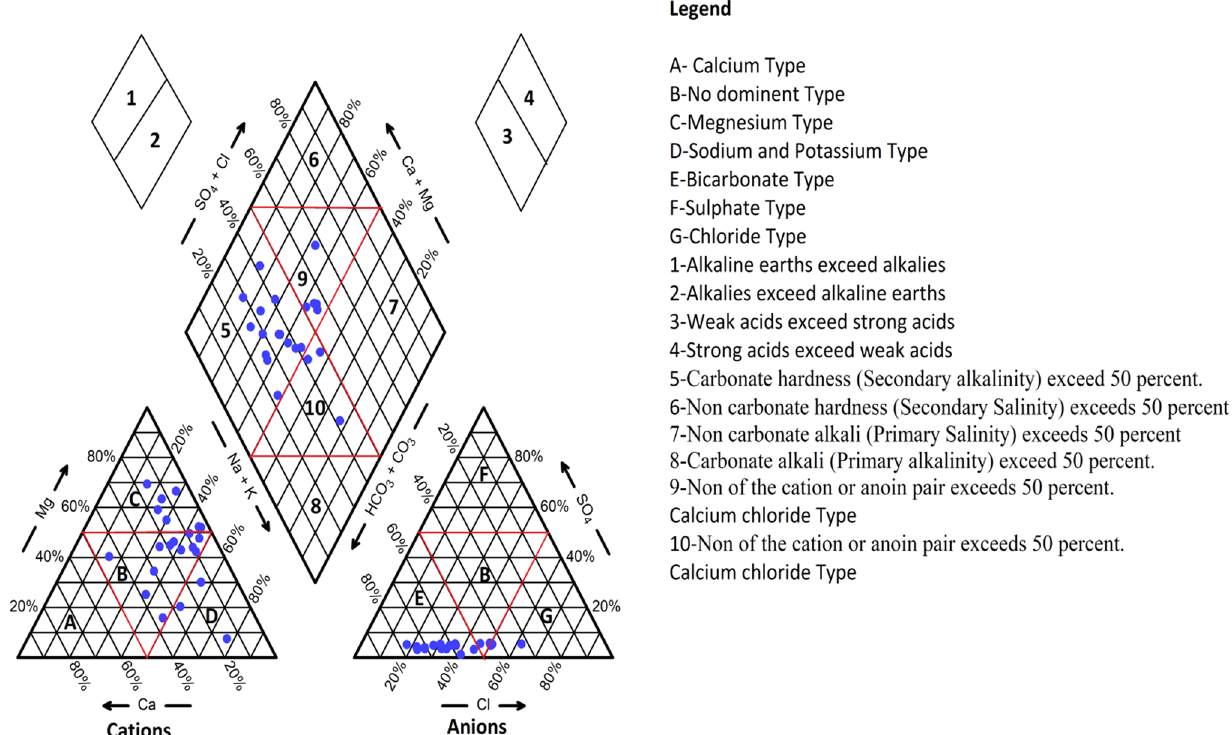
Fig. 12 Piper’s trilinear classification of groundwater in the Subledu Basin